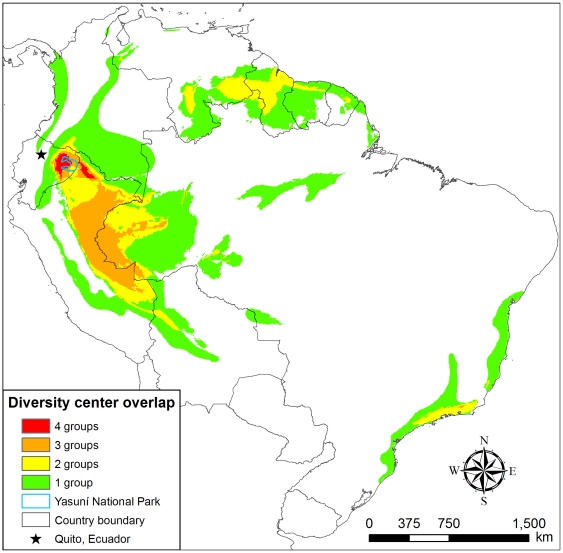
Richness center overlap.Richness center overlap of four key focus groups—amphibians, birds, mammals and vascular plants. A richness center is defined as the top 6.4% of grid cells for each taxonomic group (see Materials and Methods for details). 4 groups = area where richness centers for all four groups overlap; 3 groups = richness centers for three groups overlap; 2 groups = richness centers for two groups overlap; 1 group = richness center for just one group occurs; 0 = richness center for none of the four groups.